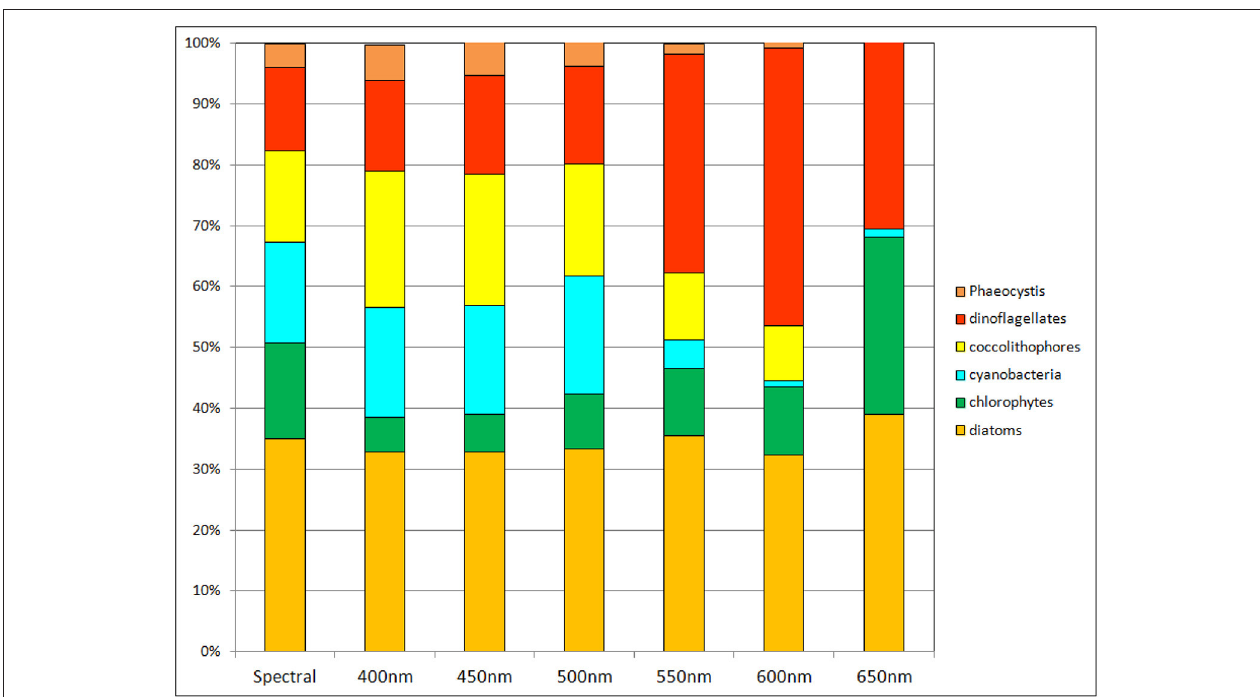
FIGURE 8 | Global net primary production using non-spectral transmittance of irradiance compared to the spectrally-resolved model. Included is the contribution of each phytoplankton component to the total.